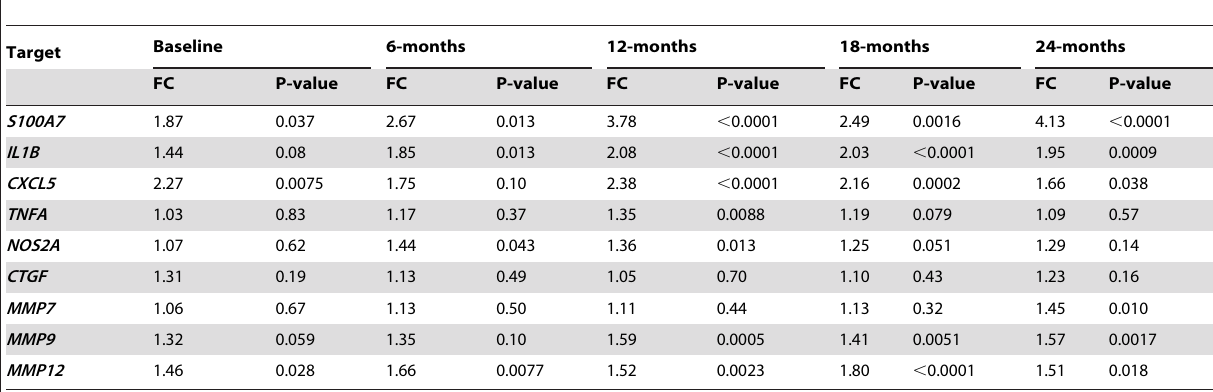
Table 4. Gene expression level in inflamed (P2/P3) individuals relative to non-inflamed individuals.